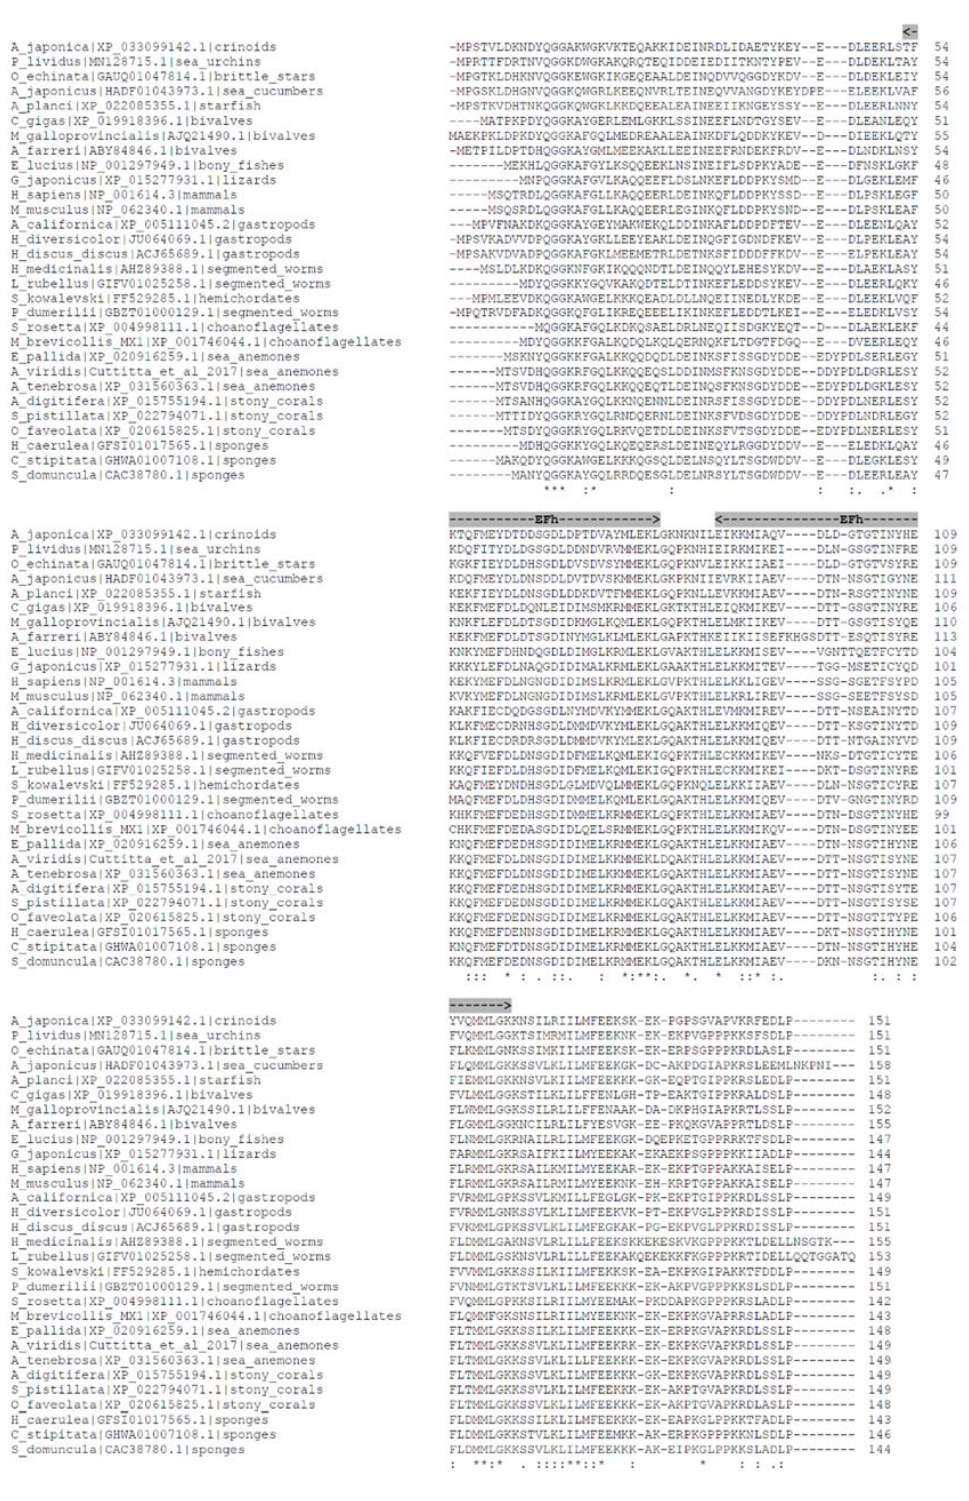
Figure 2. Multiple alignment among the sequences analyzed in Figure 1 as obtained by Clustal Omega (default parameters). EF-hand, calcium-binding motifs (Efh) are highlighted in grey. Asterisks (*) correspond to single, fully conserved residues. Colons (:) indicate conservation of residues sharing strongly similar properties (equivalent to scoring > 0.5 in the Gonnet PAM 250 matrix). Periods (.) indicate conservation of residues with weakly similar properties (equivalent to scoring ≤ 0.5 and > 0 in the Gonnet PAM 250 matrix).